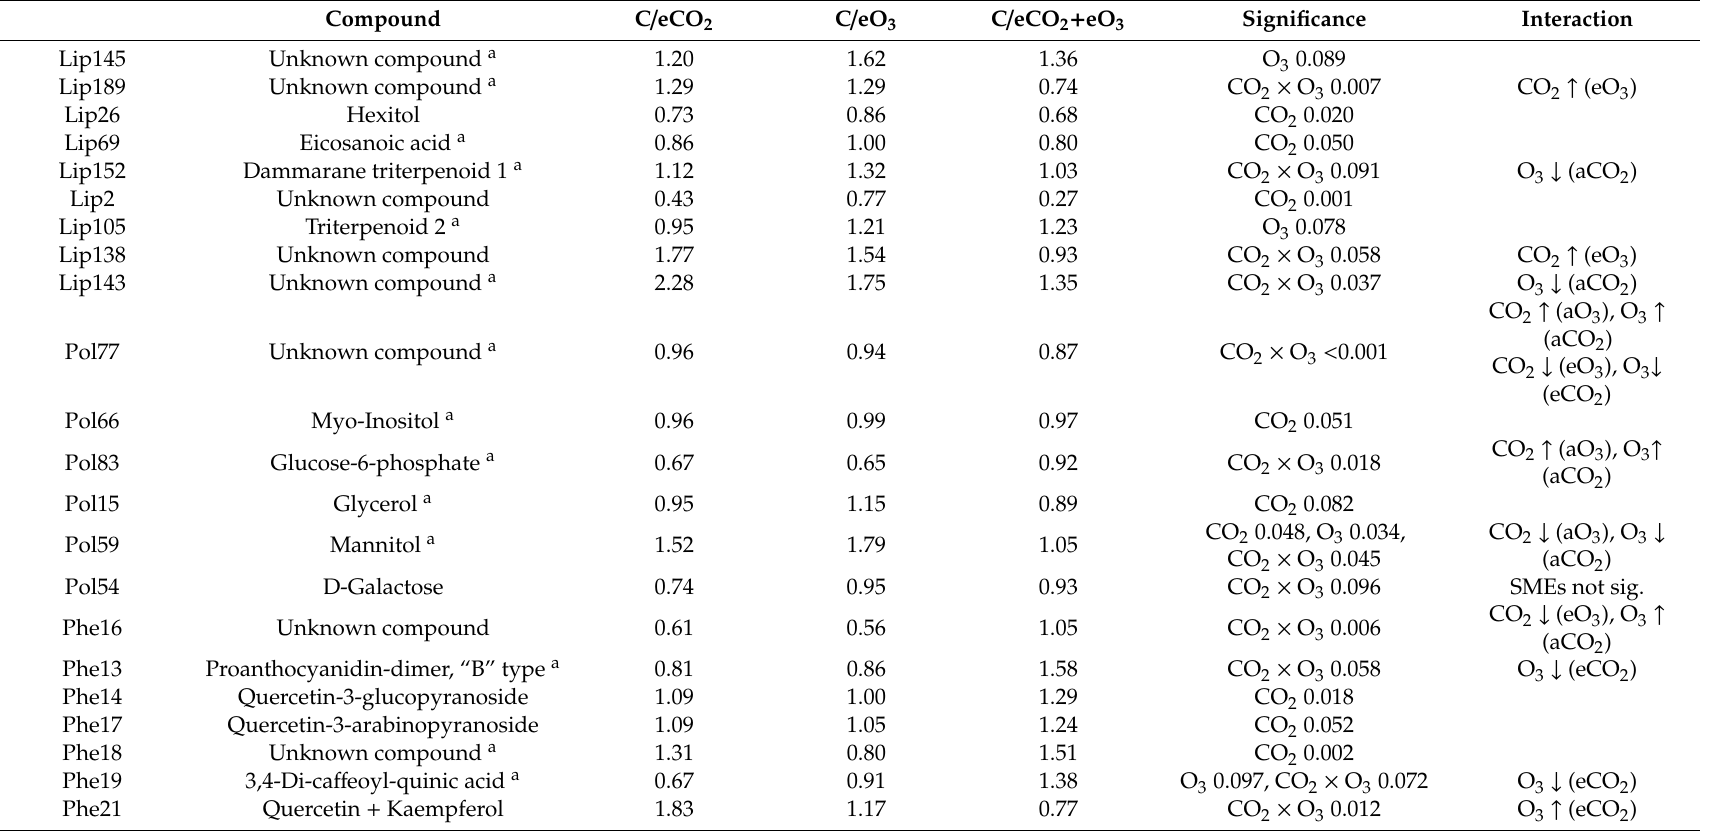
Table 3. Statistically significant metabolites that separated the control (C) and elevated CO 2 (eCO 2 ) elevated O 3 (eO 3 ) and eCO 2 + eO 3 treatments, identified from the VIP